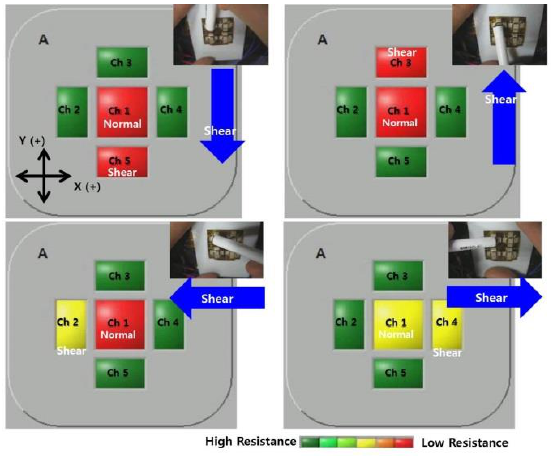
Figure 6. Screen capture of LabVIEW-controlled demonstration system to show the capability of the sensor in discriminating of applied shear force